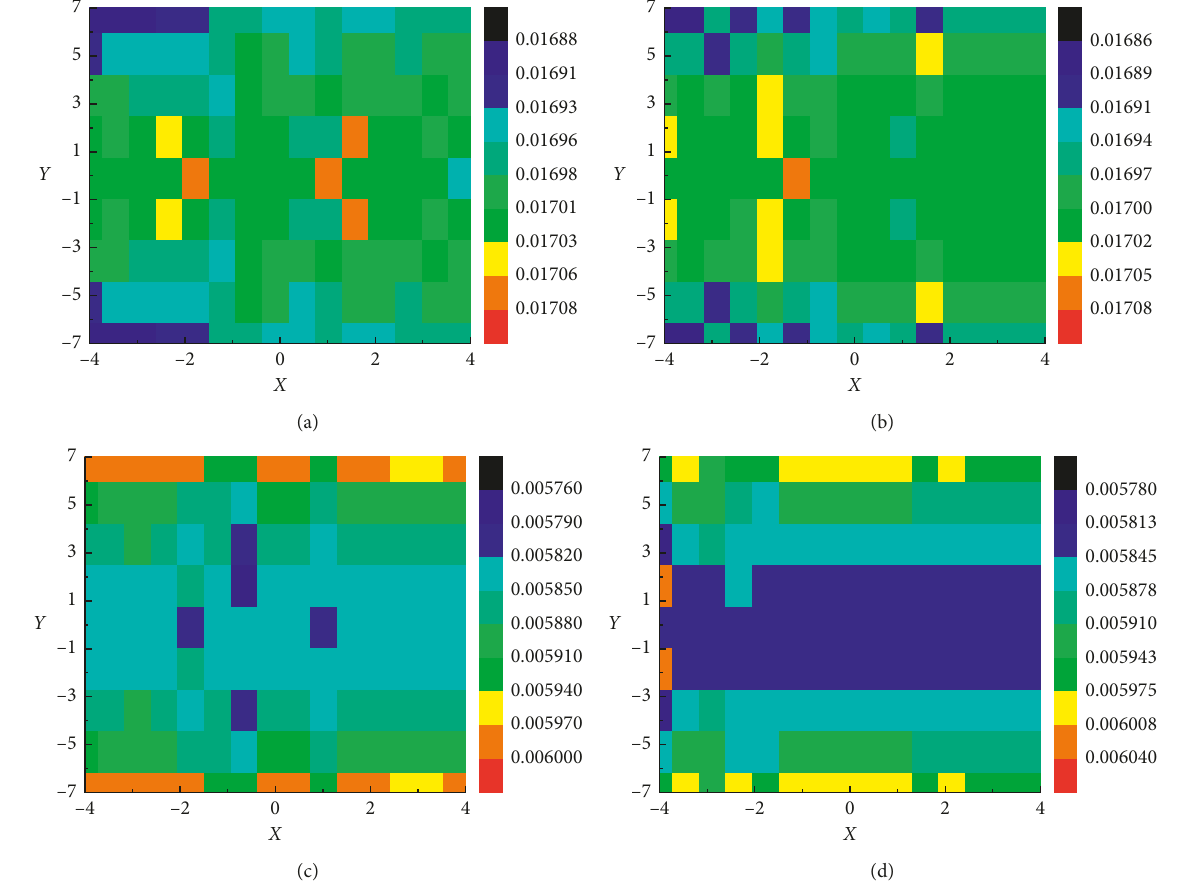
Figure 9: System response under unidirectional ground motion when primary structure is unidirectionally eccentric. (a) Displacement variance of the X direction of primary structure ( X R 1 . 6m). (b) Displacement variance of the X direction of primary structure (cid:29) 2 . 7m). (c) Displacement variance of the X direction of secondary structure ( X R 1 . 6m). (d) Displacement variance of the X ( X R (cid:29) (cid:29) 2 . 7m). direction of secondary structure ( X R (cid:29)